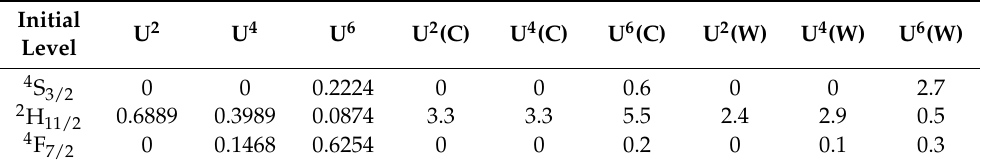
Table 4. Average RME values estimated from squared RMEs listed in Table 3. Deviations of average values from squared RMEs reported by Carnall (C) and Weber (W), in